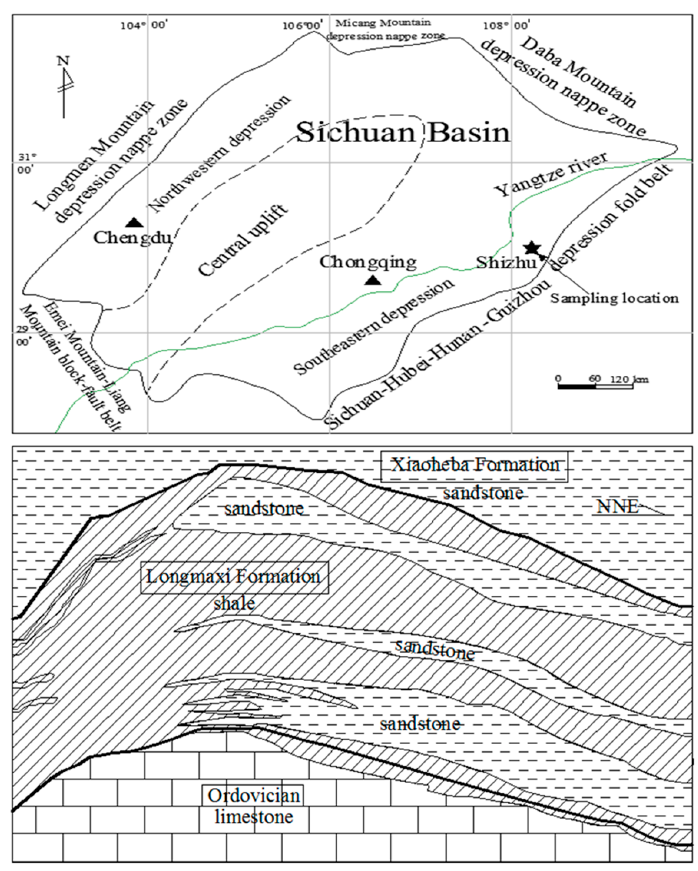
Figure 2. Geological structure distribution of the Sichuan Basin and sampling location ( ★ ) in this study [37].